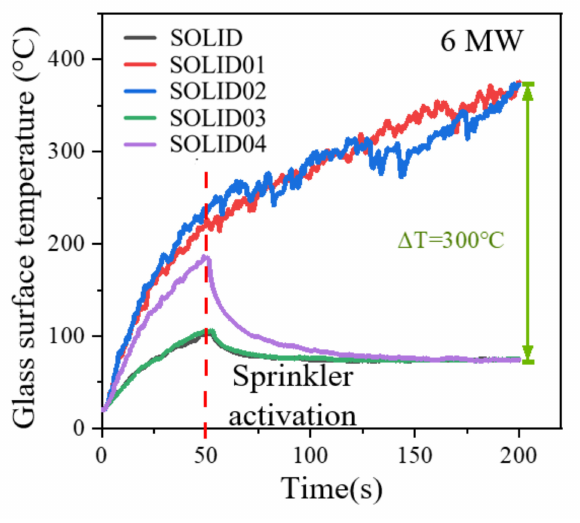
Figure 25. Glass surface temperature change under window sprinkler conditions. Figure 26a is the temperature distribution of the glass surface temperature field at 50